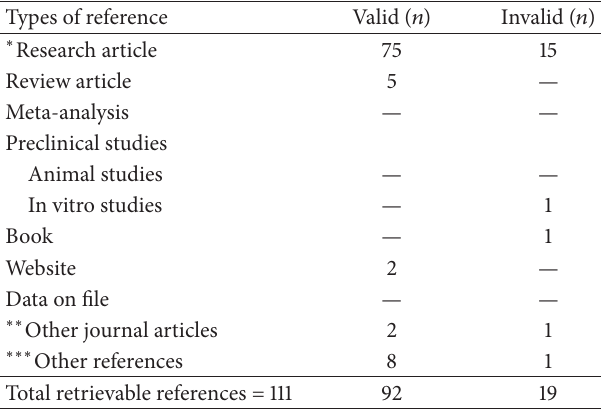
Table 5: Classification of retrievable references.